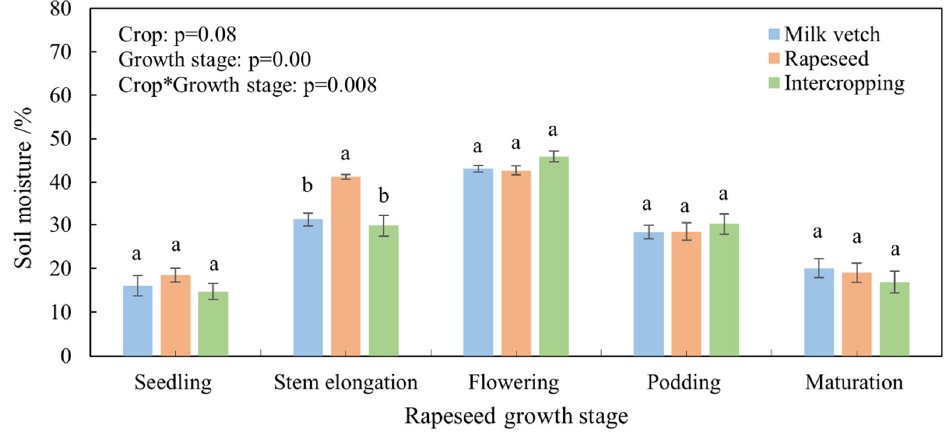
Figure 2. Changes in soil moisture during rapeseed growth stages. Crop represents crop planting patterns (Milk vetch, Rapeseed, Intercropping), Growth stage represents crop growth stages (seeding, stem elongating, flowering, podding, maturation), and Crop*Growth stage represents the interaction between planting pattern and growth stage. Letters represent the significant differences ( p < 0.05) between crops at each growth stage.